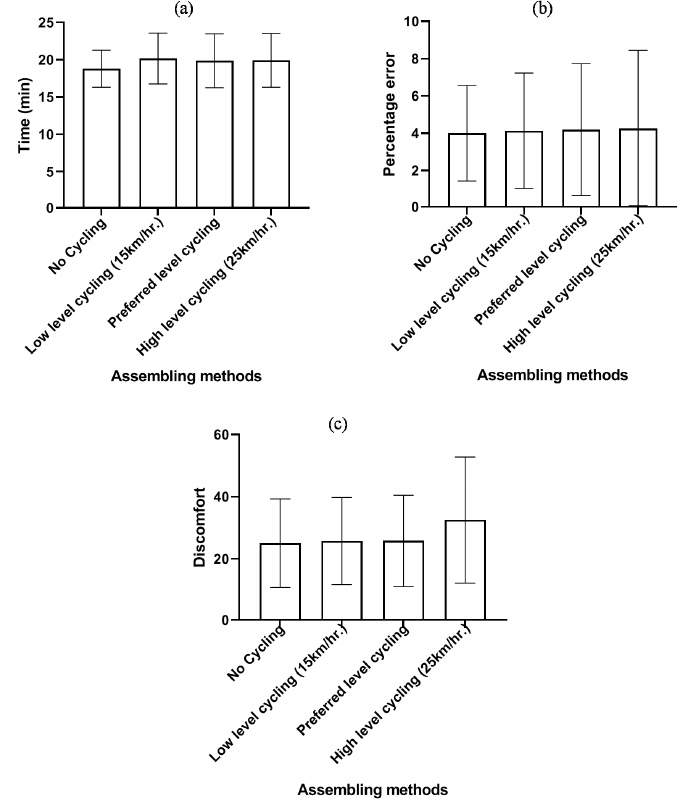
Table 1. Mean (standard deviation) for time, discomfort, and error.